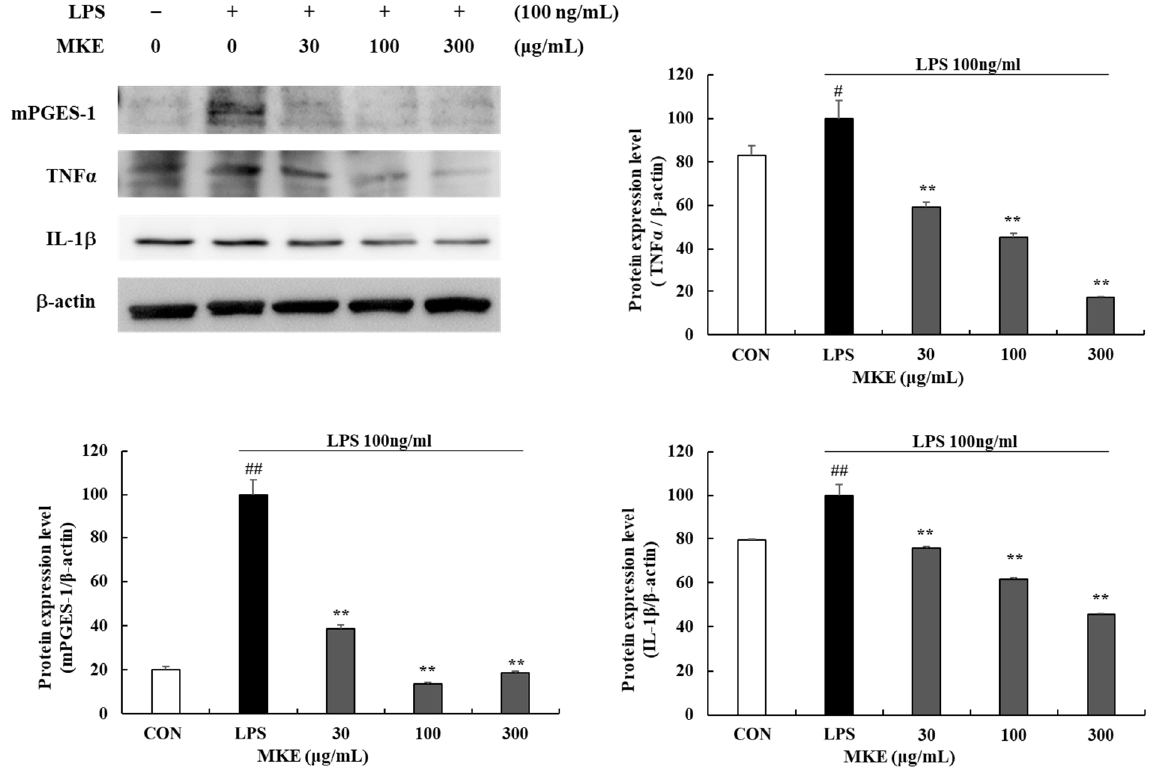
Figure 4. Effects of MKE (30, 100, and 300 μg/mL) on the production of inflammatory mediators in LPS-stimulated RAW 264.7 cells. MKE and 100 ng/mL of LPS was added except for the vehicle control group and incubated at 37 °C for 24 h. Protein expression levels of TNF-α, IL-1β and mPGES-1 were detected by Western blot. The protein band density was measured by utilizing the ImageJ software. β-actin was used as a control. Values represent means ± standard deviation. # p < 0.05 and ## p < 0.01 vs. Vehicle control group; ** p < 0.01 vs. LPS-activated control group. In groups treated with 0.45, 1.5, and 4.5 μg/mL magnolin, TNF-α expression levels were reduced by 9.95 (±1.38)%, 45.21 (±2.75)%, and 61.12 (±0.84)%, respectively, and IL-1β expression levels were decreased by 29.76 (±4.11)%, 34.62 (±1.68)%, and 26.73 (±4.99)%, respectively ( ** p < 0.01) (Figure 5). Furthermore, in cells treated with 1.5 and 4.5 μg/mL magnolin, mPGES-1 protein expression levels were decreased by 23.04 (±3.55)% and 37.55 (±3.96)%, respectively ( ** p < 0.01). These results indicate that magnolin might inhibit in- flammatory mediators as a biologically active compound in MKE. MKE and magnolin did not decrease cell viability at the concentrations tested, indicating that their inhibitory ef- fects on inflammatory mediator production were not related to their cytotoxicity.